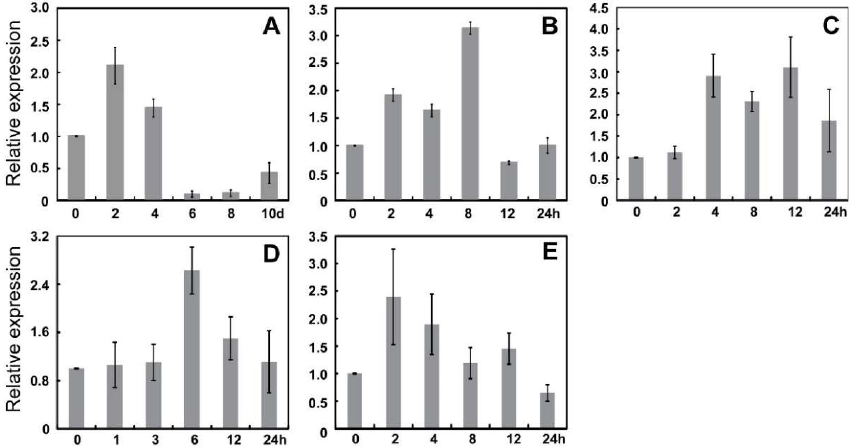
Figure 6. The expression pattern of MdWRKY70L under different stress treatments. ( A ) Drought stress treatment; ( B ) ABA treatment; ( C ) Salt stress treatment; ( D ) Alkali stress treatment; ( E ) Low temperature treatment. MdMDH was used as the internal reference and the expression data on 0 h or 0 d were normalized to “1”. The error bars indicate the standard deviation between four replicates.